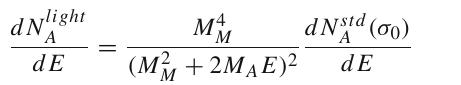
Fig. 8 Left: comparison of the nucleus recoil distributions after fold- ing in the XENON1T acceptance, p ef f , for a heavy mediator M M = 100 GeV (full) and M χ = 10 , 15 GeV with that of a light mediator,